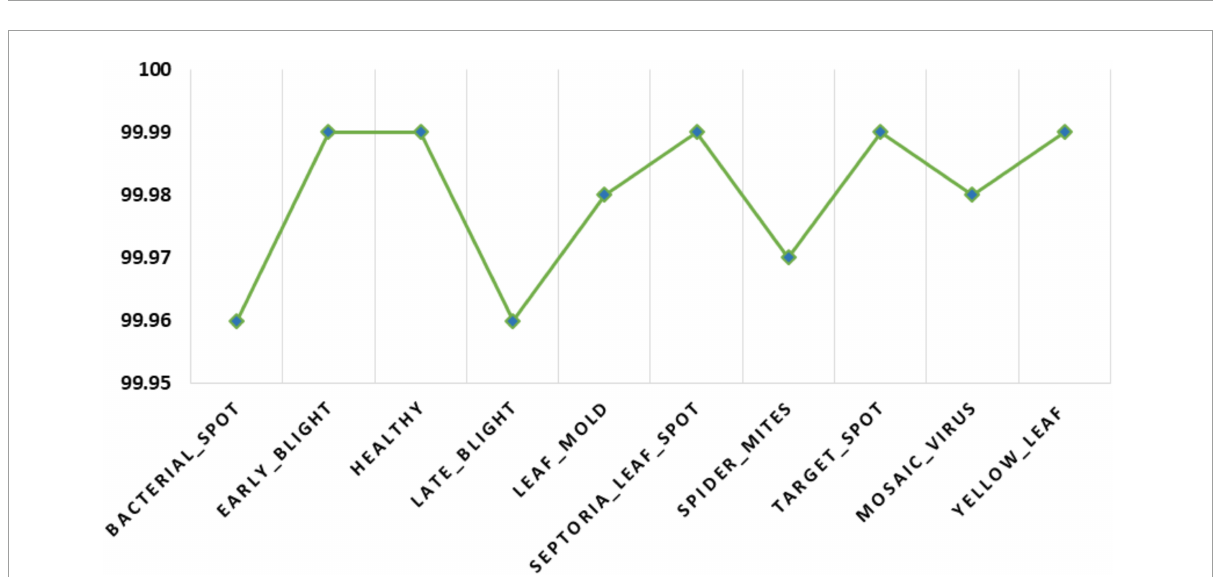
FIGURE11 A pictorial depiction of the class-wise accuracy values obtained for the DenseNet-77-based CornerNet model.